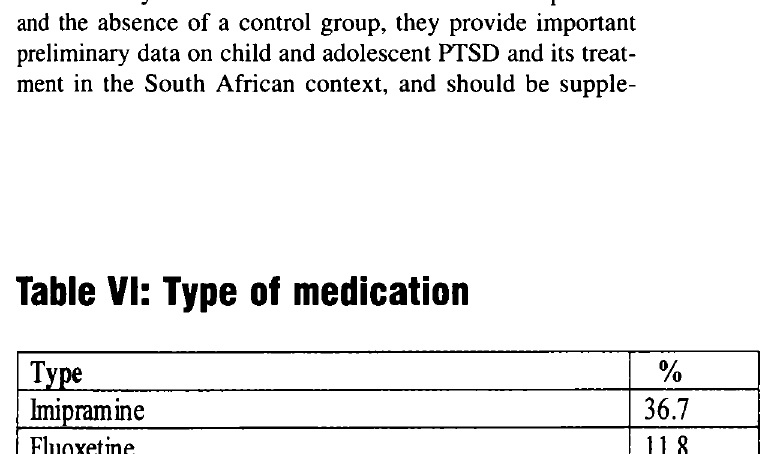
Table V II: Outcome (Clinical Global Impression -